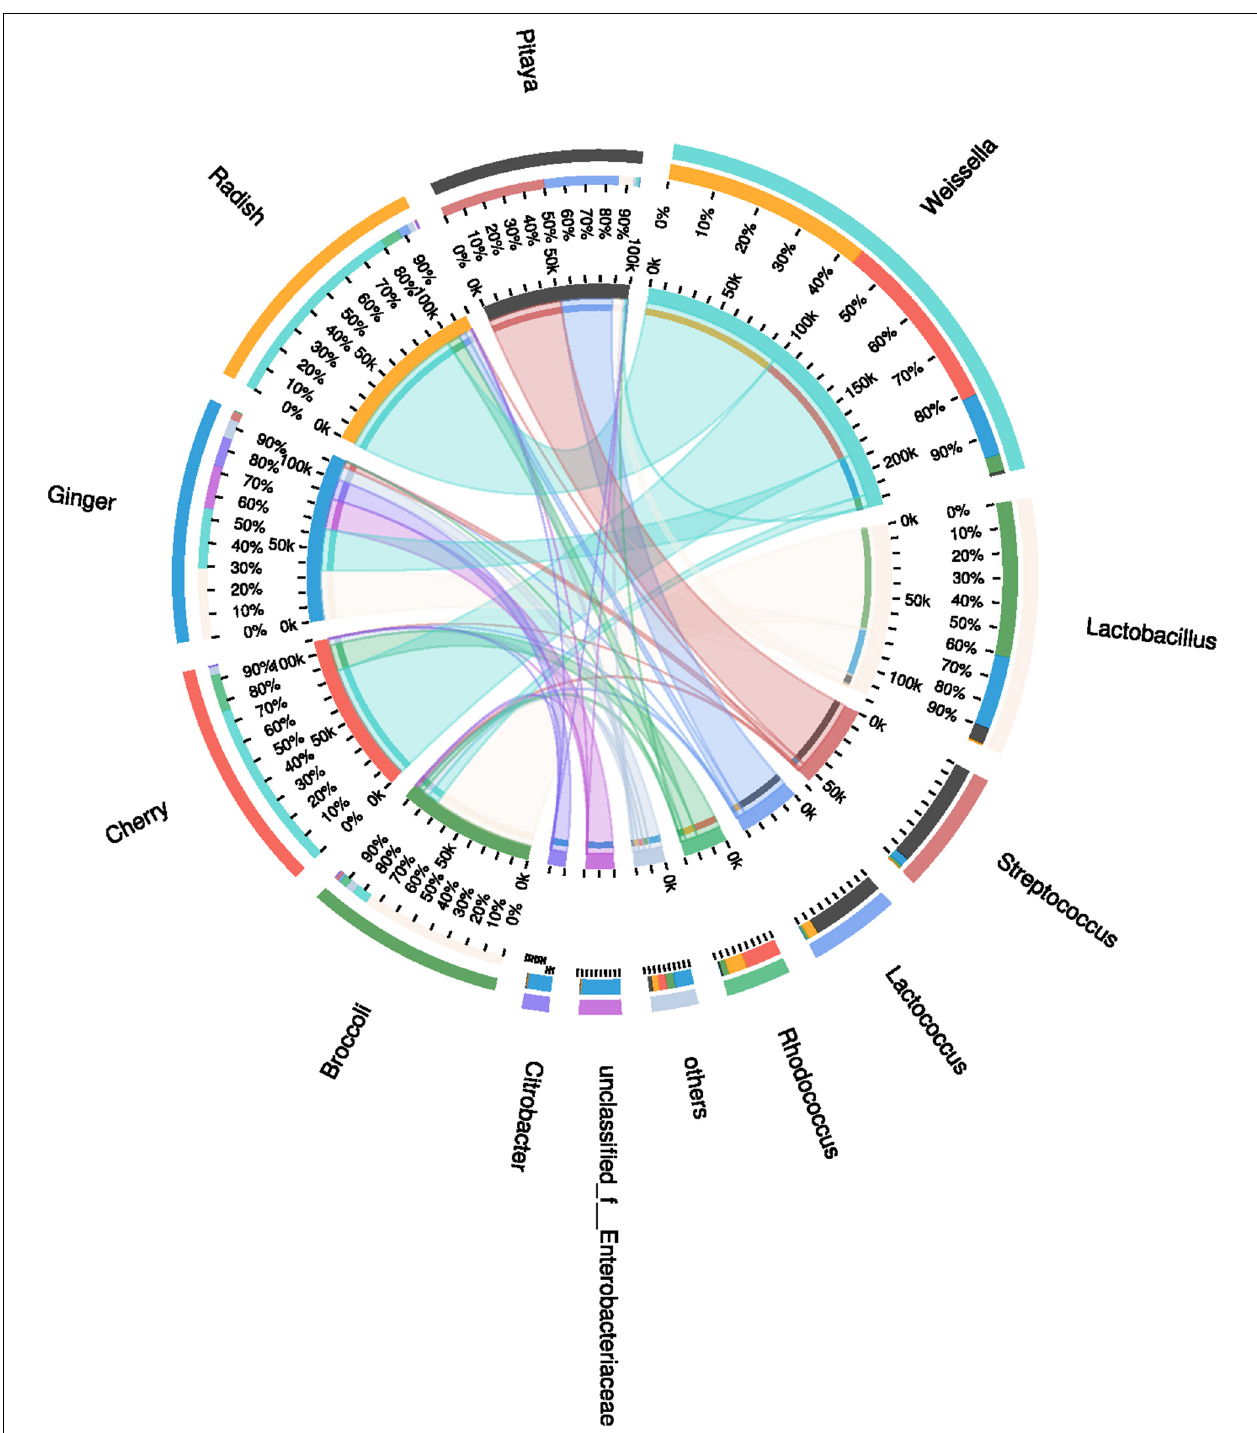
FIGURE 1 | Distribution of the microbial community for each sample at the genus level. The data were visualized by Circos. The small semi-circle (left) shows the composition and abundance of species in each sample. The large semi-circle (right) shows the distribution ratio of samples within the dominant species, and the width of the bars for each genus indicates the relative abundance of that genus in the sample. From the outer circle to the inner circle, the outer circle shows the different samples and species using specific colors, and the length is related to the distribution proportion. The second circle shows the percentage. In the innermost circle, the two ends of each chromatic stripe connect the sample with the dominant genus; the width of the stripe at the endpoint represents the abundance and distribution proportion, and the numerical value outside the circle represents the abundance values of the corresponding samples and species.